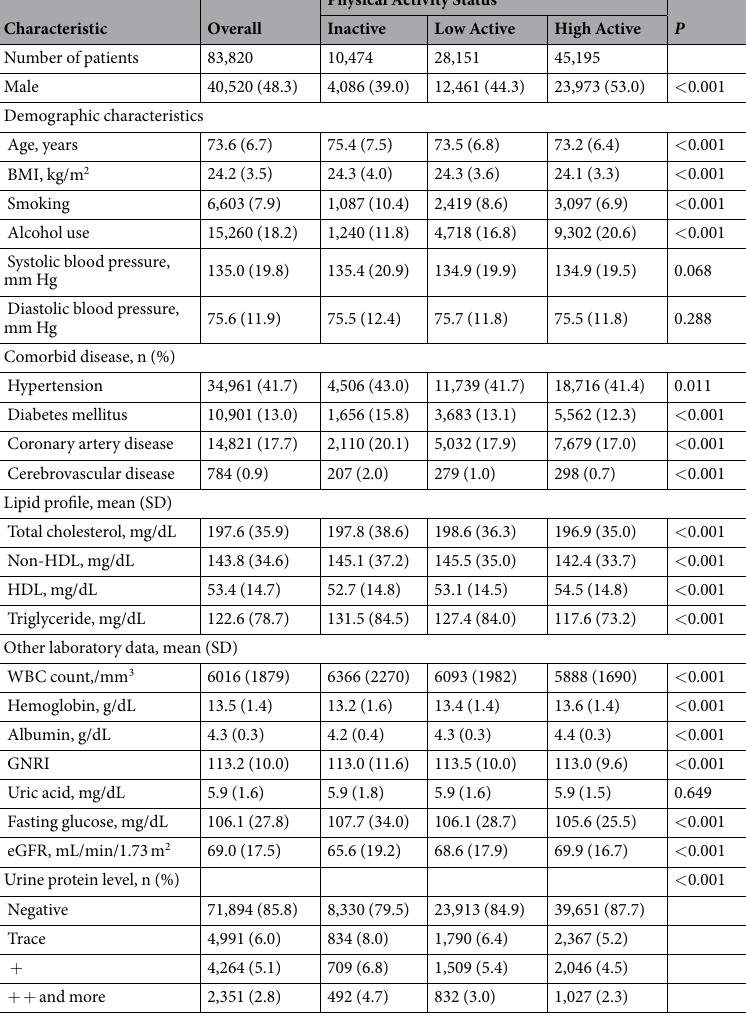
Table 1. Demographic and Clinical Characteristics of the Study Population. Data are presented as n (%) or mean ± standard deviation. Abbreviations: BMI, body mass index; SD, standard deviation; HDL, high-density lipoprotein; WBC, white blood cell; GNRI, Geriatric nutritional risk index; eGFR, estimated glomerular filtration